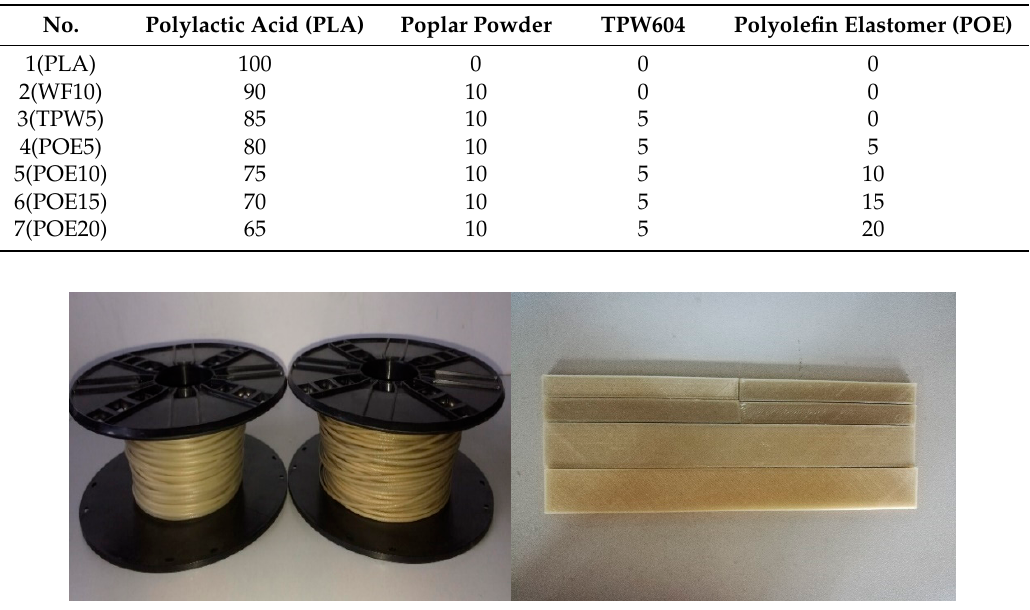
Table 1. The content of different ingredients in the formula (wt %).